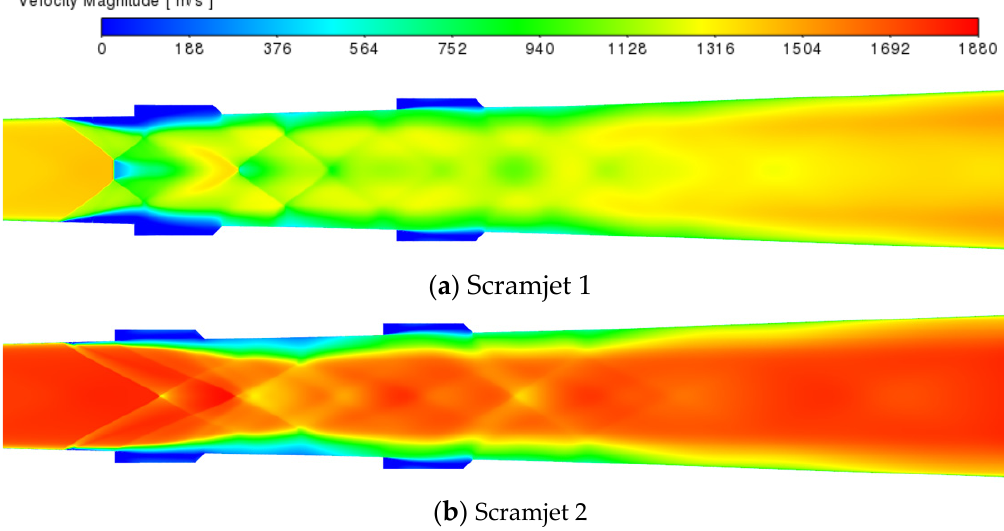
Figure 8. Velocity magnitude contours for scramjet 1 and scramjet